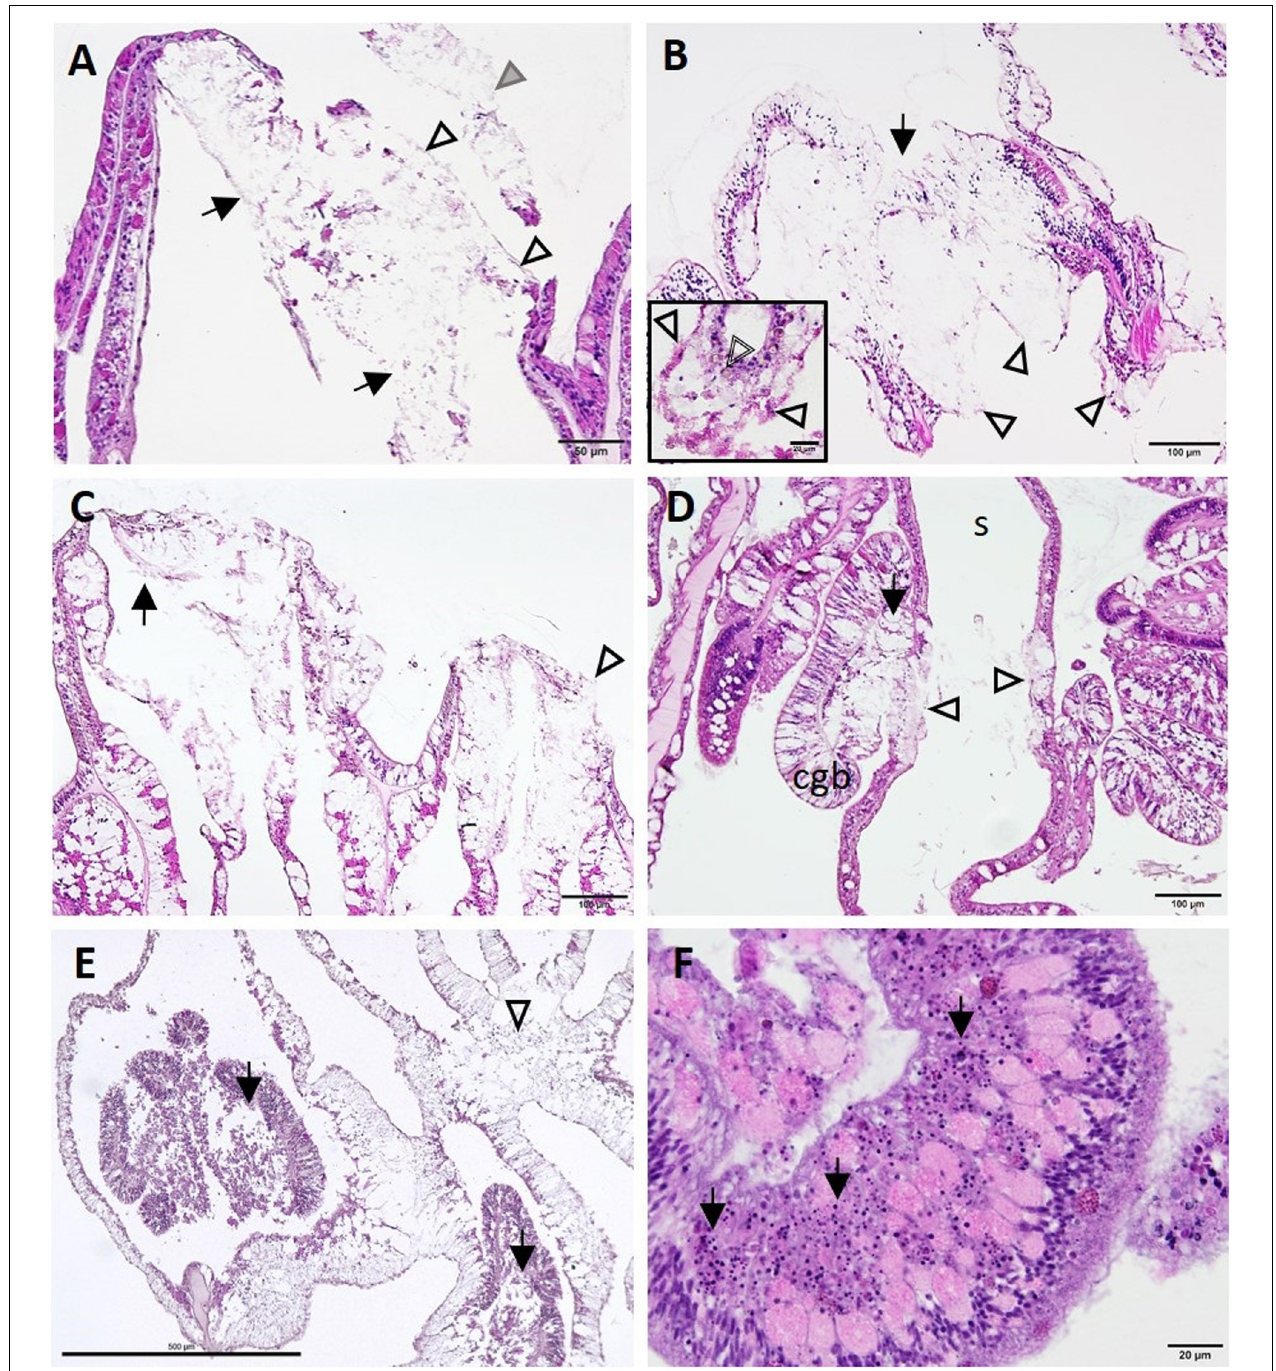
FIGURE 11 | Lesion progression toward advanced tissue loss (A–C) and spread to various tissue compartments (D–F) . (A) Advanced lytic necrosis (LN) in the basal body wall (BBW) (arrows) and surface body wall (SBW) (open arrowheads) of Dendrogyra cylindrus at the tissue-loss margin. Note almost complete LN of the BBW and SBW and sloughing of necrotic SBW (gray arrowhead). (B) Advanced LN at the tissue-loss margin in Siderastrea siderea . Note segmental necrosis of the BBW and SBW (arrow) and remnant calicodermal layer (arrowheads). Inset high magnification showing deeper mesentery with eosinophilic calicoblasts manifesting CARPs (arrowheads) and a brown necrotic zooxanthella (double-line arrowhead). (C) Severe LN in Orbicella faveolata at the tissue loss margin (arrow). Note more diffuse segmental necrosis (arrowhead) compared with (B) . (D) LN in the mesentery and cnidoglandular band (CGB) adjacent to LN in the BBW of Montastraea cavernosa . Note CGB vacuolation and necrosis (arrow) and BBW LN on either side of the skeleton (arrowheads). (E) Deeper in the polyp in O. faveolata , note diffuse coagulation necrosis of the mesenterial filaments (arrows) and the BBW (arrowhead). (F) Diffuse necrosis (karyorrhexis) of the tentacular gastrodermis (arrows) in D. cylindrus (JB-4 medium). Hematoxylin and eosin (H and E), cgb, cnidoglandular band; s, skeleton.